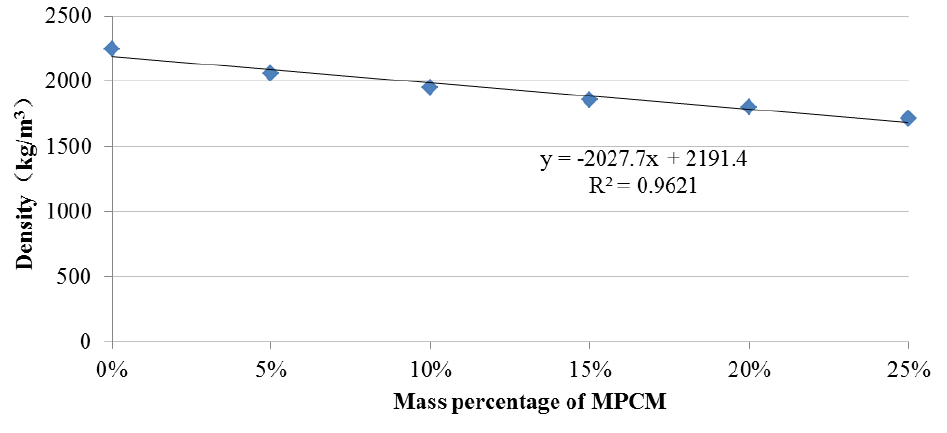
Figure 19. Density of hardened cement paste with different mass percentages of